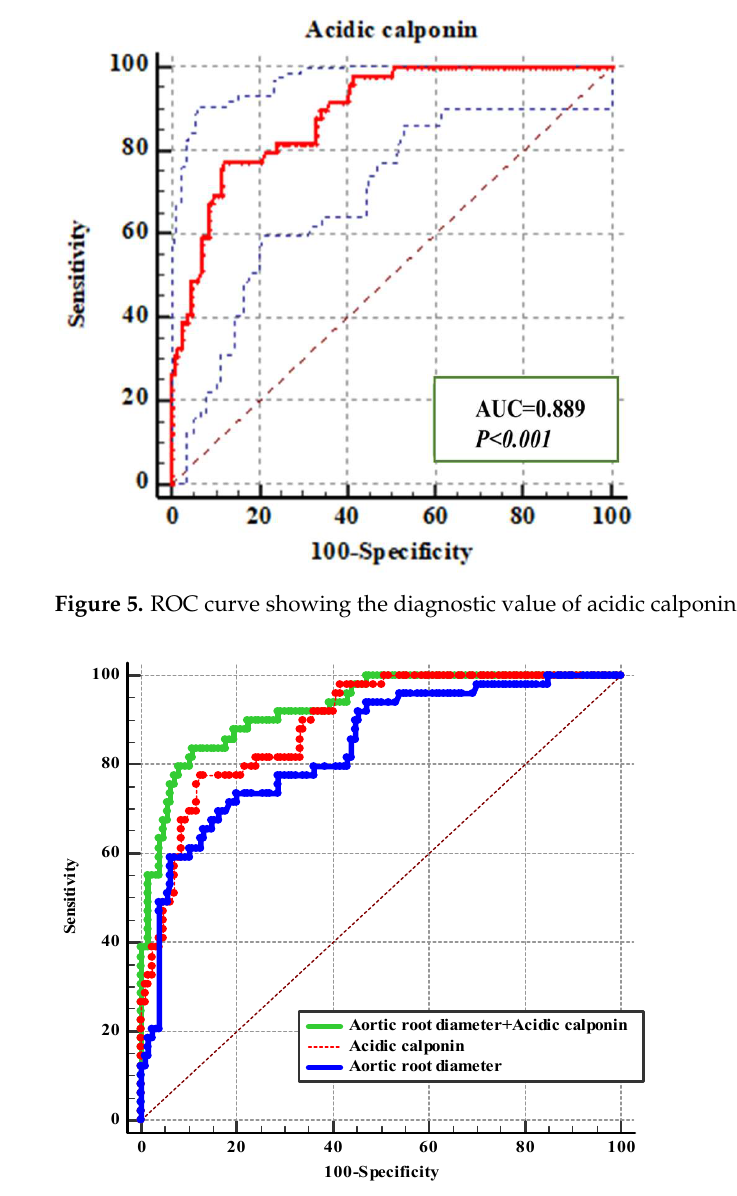
Figure 6. ROC curve showing the combined diagnostic performance of ascending aorta root diameter and acidic calponin for A-AAS.